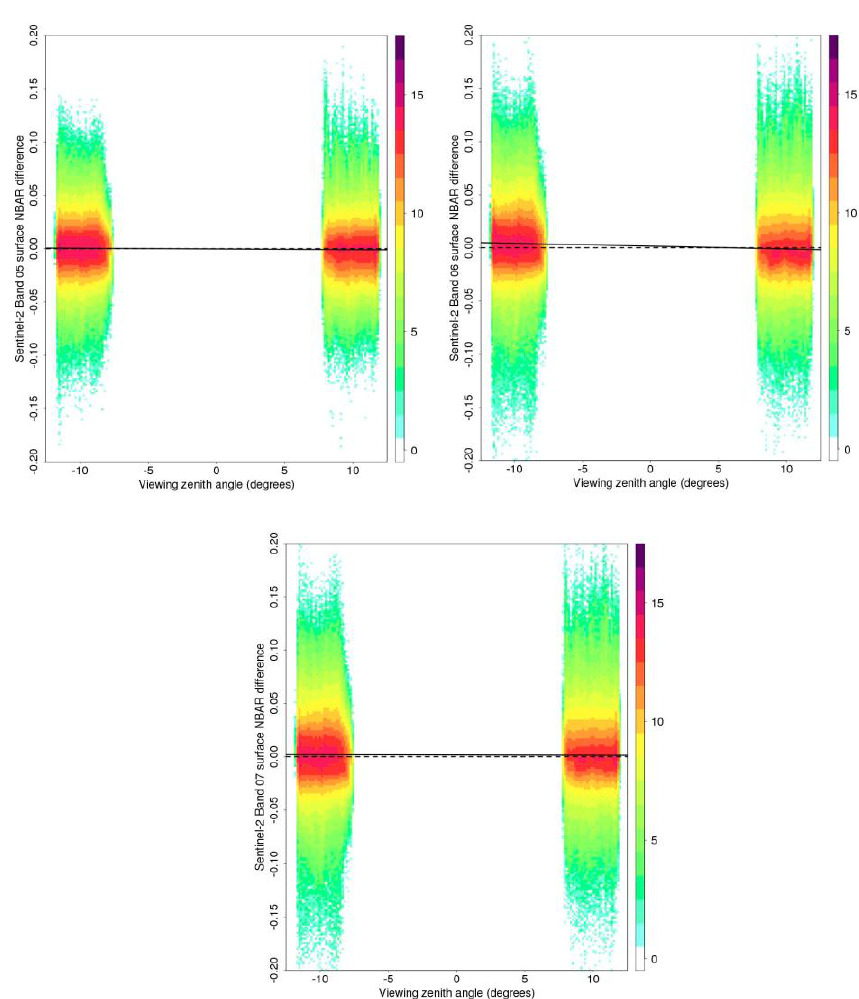
Figure 7. Same as Figure 6 but for the April data, a total of 10,656,197 pairs of forward and back scatter surface NBAR values were considered. The solid lines show ordinary least squares (OLS) linear regression fits of these data (see Table 6).